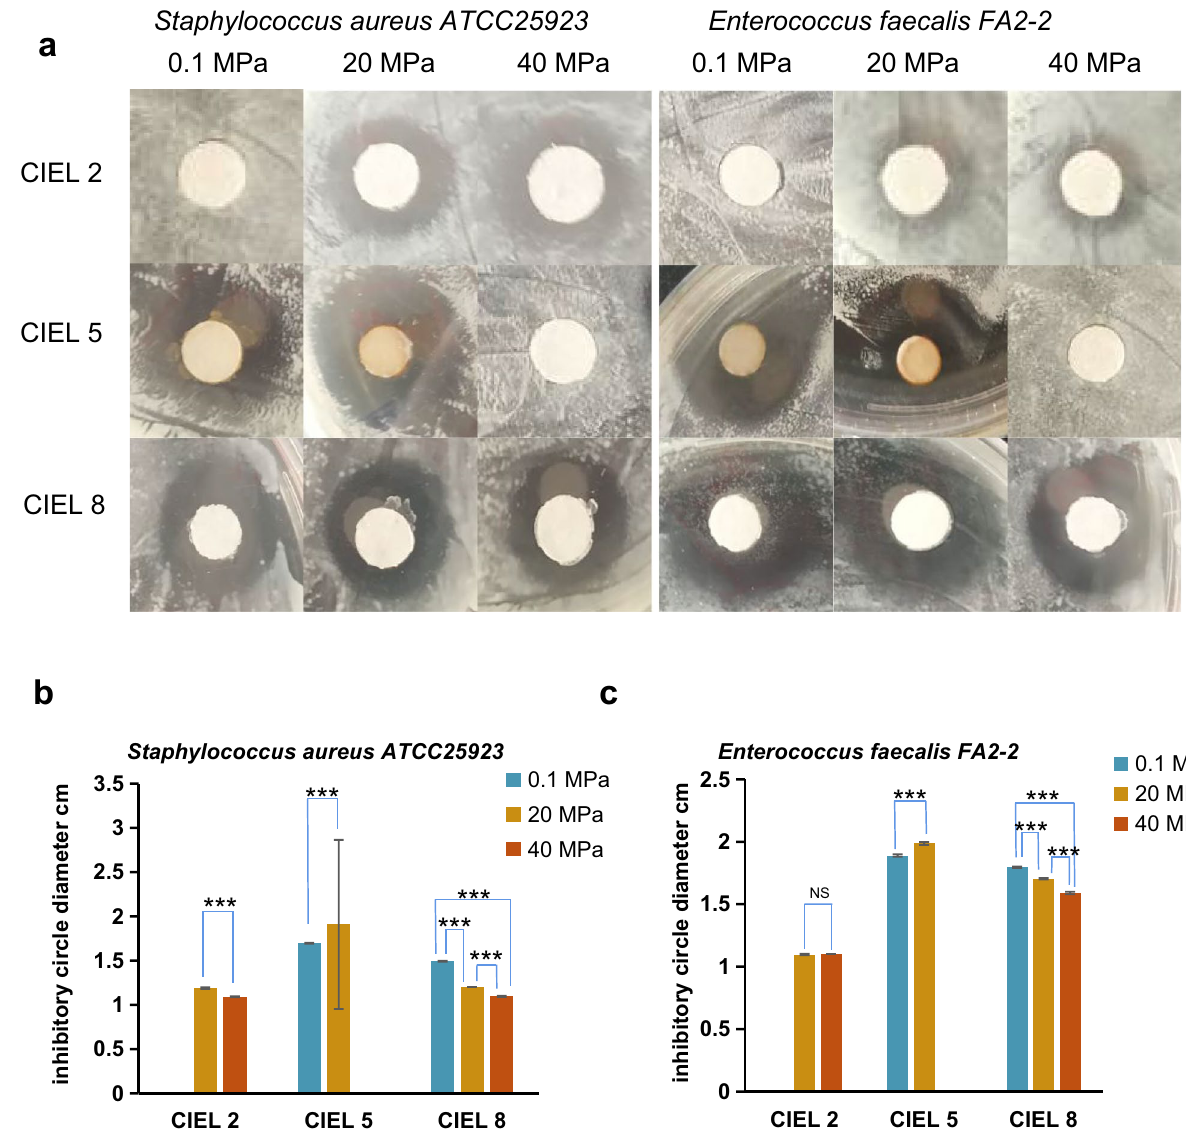
Figure 6. Antimicrobial activity of metabolites of hadal-derived fungi isolated and cultured under three preset hydrostatic pressures. Among the eight strains of fungi isolated in this experiment, Antimicrobial activity of metabolites produced by Cladosporium sp. CIEL 2, Stemphylium vesicarium CIEL 5 and Cladosporium sp . CIEL 8 against Staphylococcus aureus ATCC25923 and Enterococcus faecalis FA2-2 under 0.1, 20 and 40 MPa. ( a ) The inhibitory zone of metabolites produced by fungi under different pressures. ( b ) Antimicrobial zone diameter of the metabolites against S. aur eus ATCC25923. The diameter unit was cm. T-test was used for pairwise comparisons. The activity of the Stemphylium vesicarium CIEL 5 metabolic products increases with the increase of pressure. However, the activity of the Cladosporium sp. CIEL 2 and Cladosporium sp . CIEL 8 metabolic products decreases with the increase of pressure. (*** p < 0.001). ( c ) Antimicrobial zone diameter of the metabolites against E. faecalis FA2-2. The diameter unit was cm. T-test was used for pairwise comparisons. Cladosporium sp. CIEL 2 metabolic products are inactive, the activity of the Stemphylium vesicarium CIEL 5 metabolic products increases with the increase of pressure, and the activity of the Cladosporium sp . CIEL 8 metabolic products decreases with the increase of pressure (NS p > 0.05, *** p <